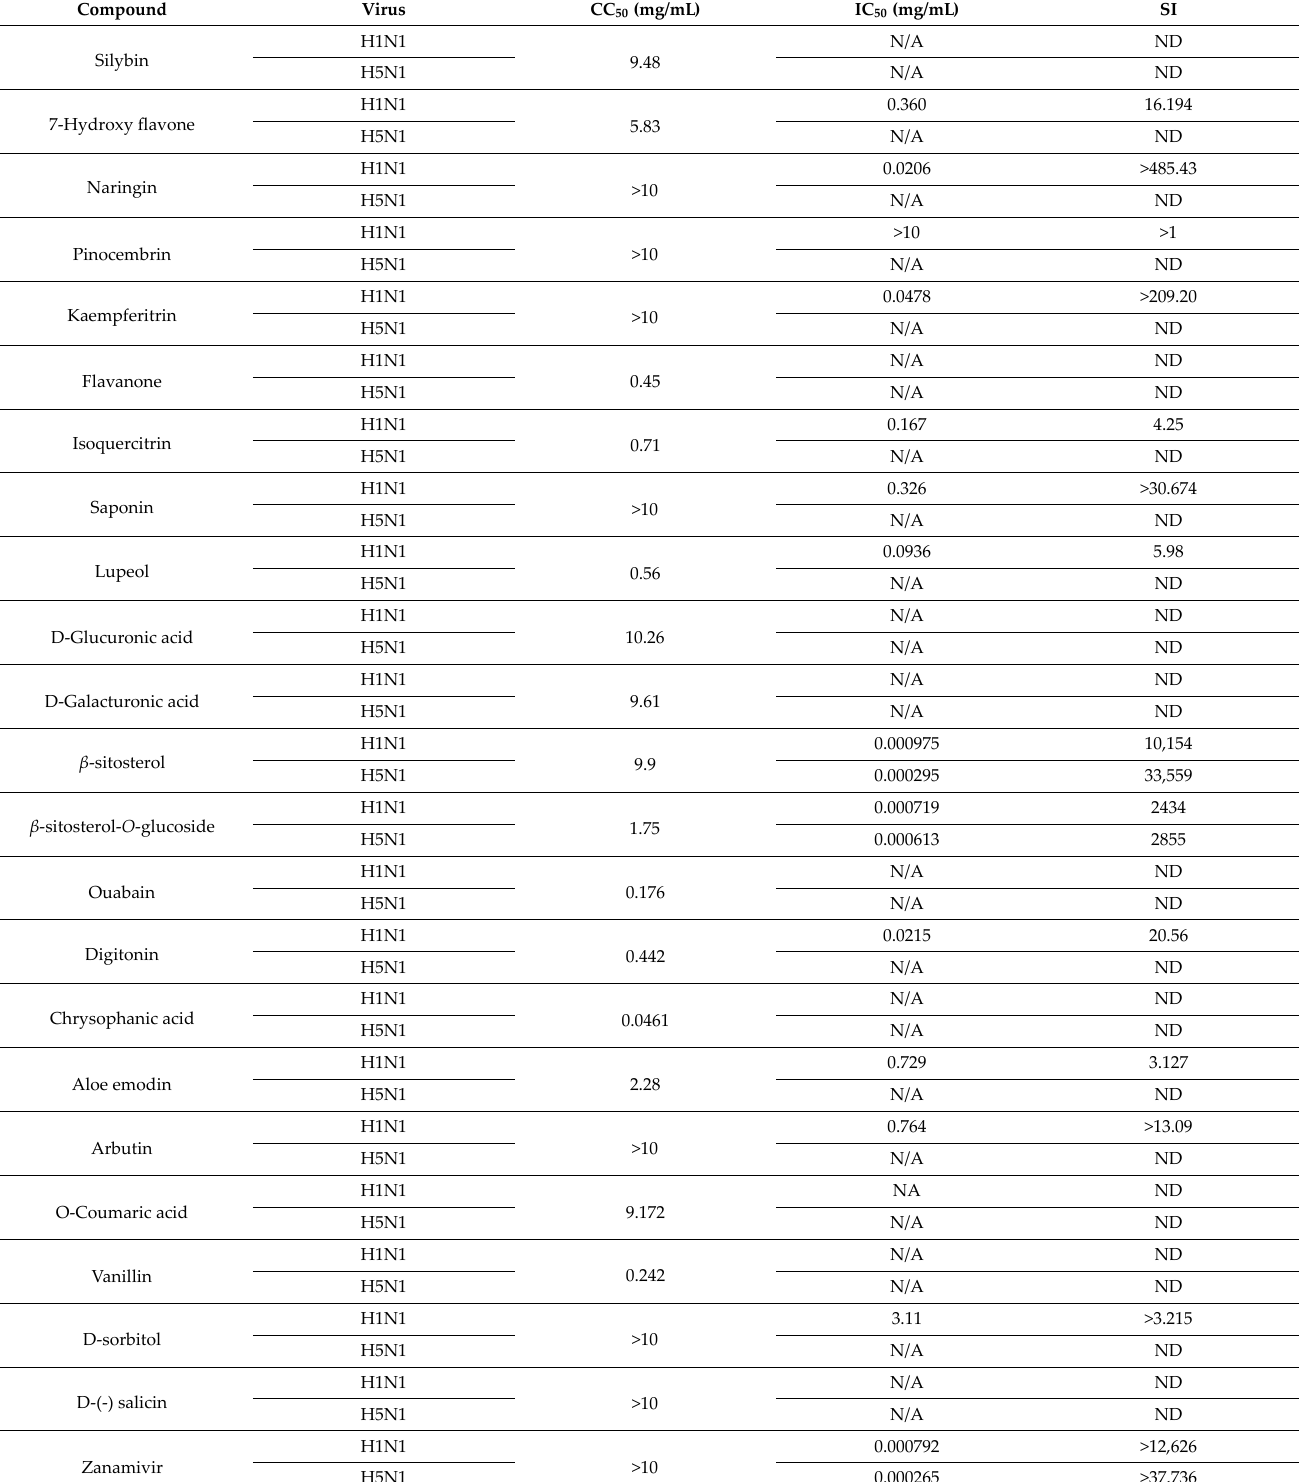
Table 2. Selectivity indices for the screened compounds against influenza A/H1N1 and A/H5N1